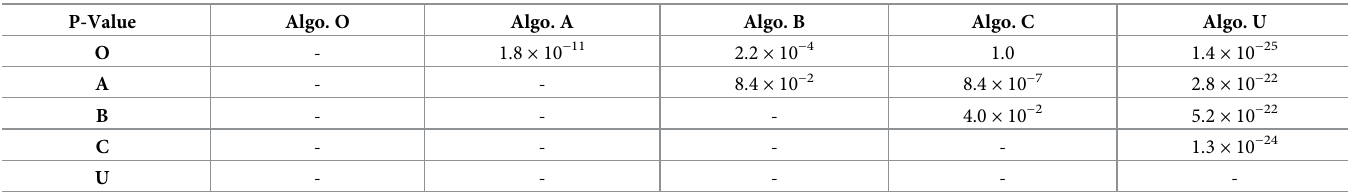
Table 2. P-values calculated with the Bonferroni correction for the algorithms.